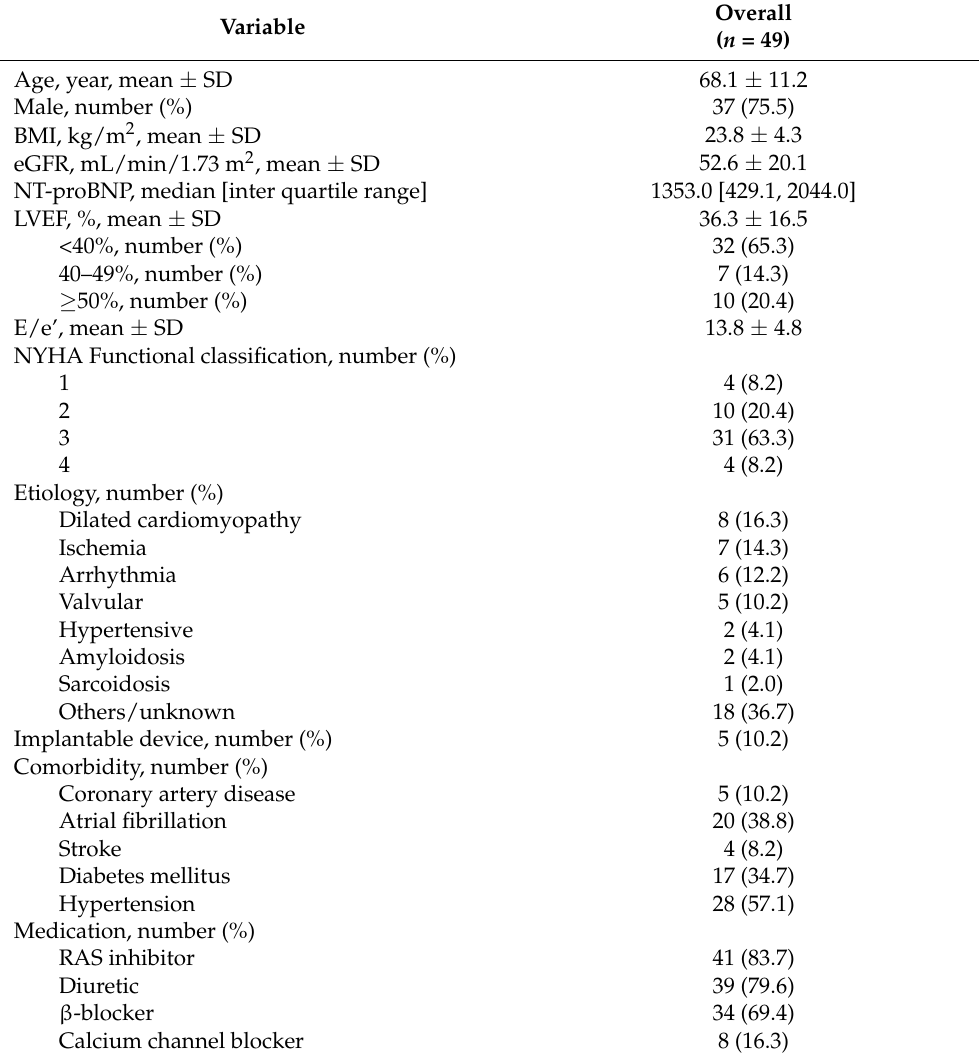
Table 1. Baseline clinical